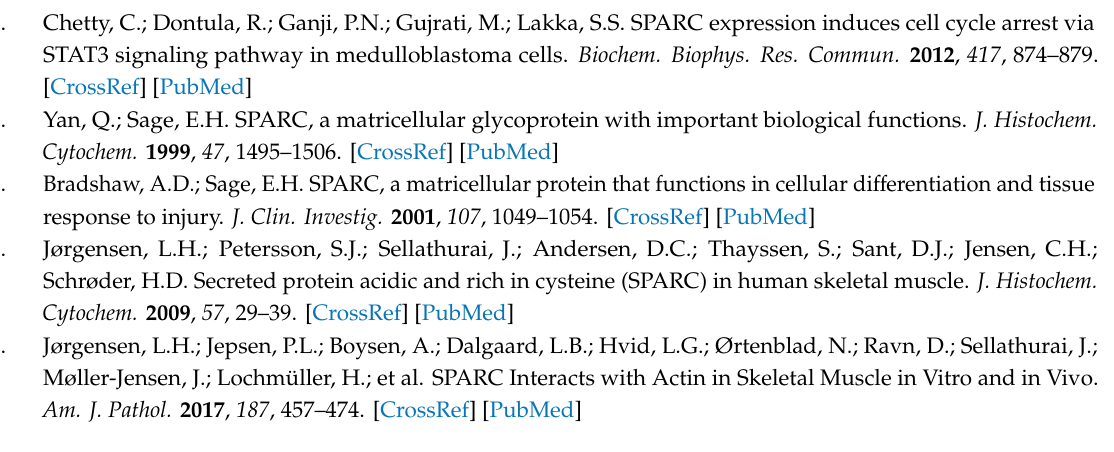
Table S1: The QE mass spectrometry results of the proteins bound with